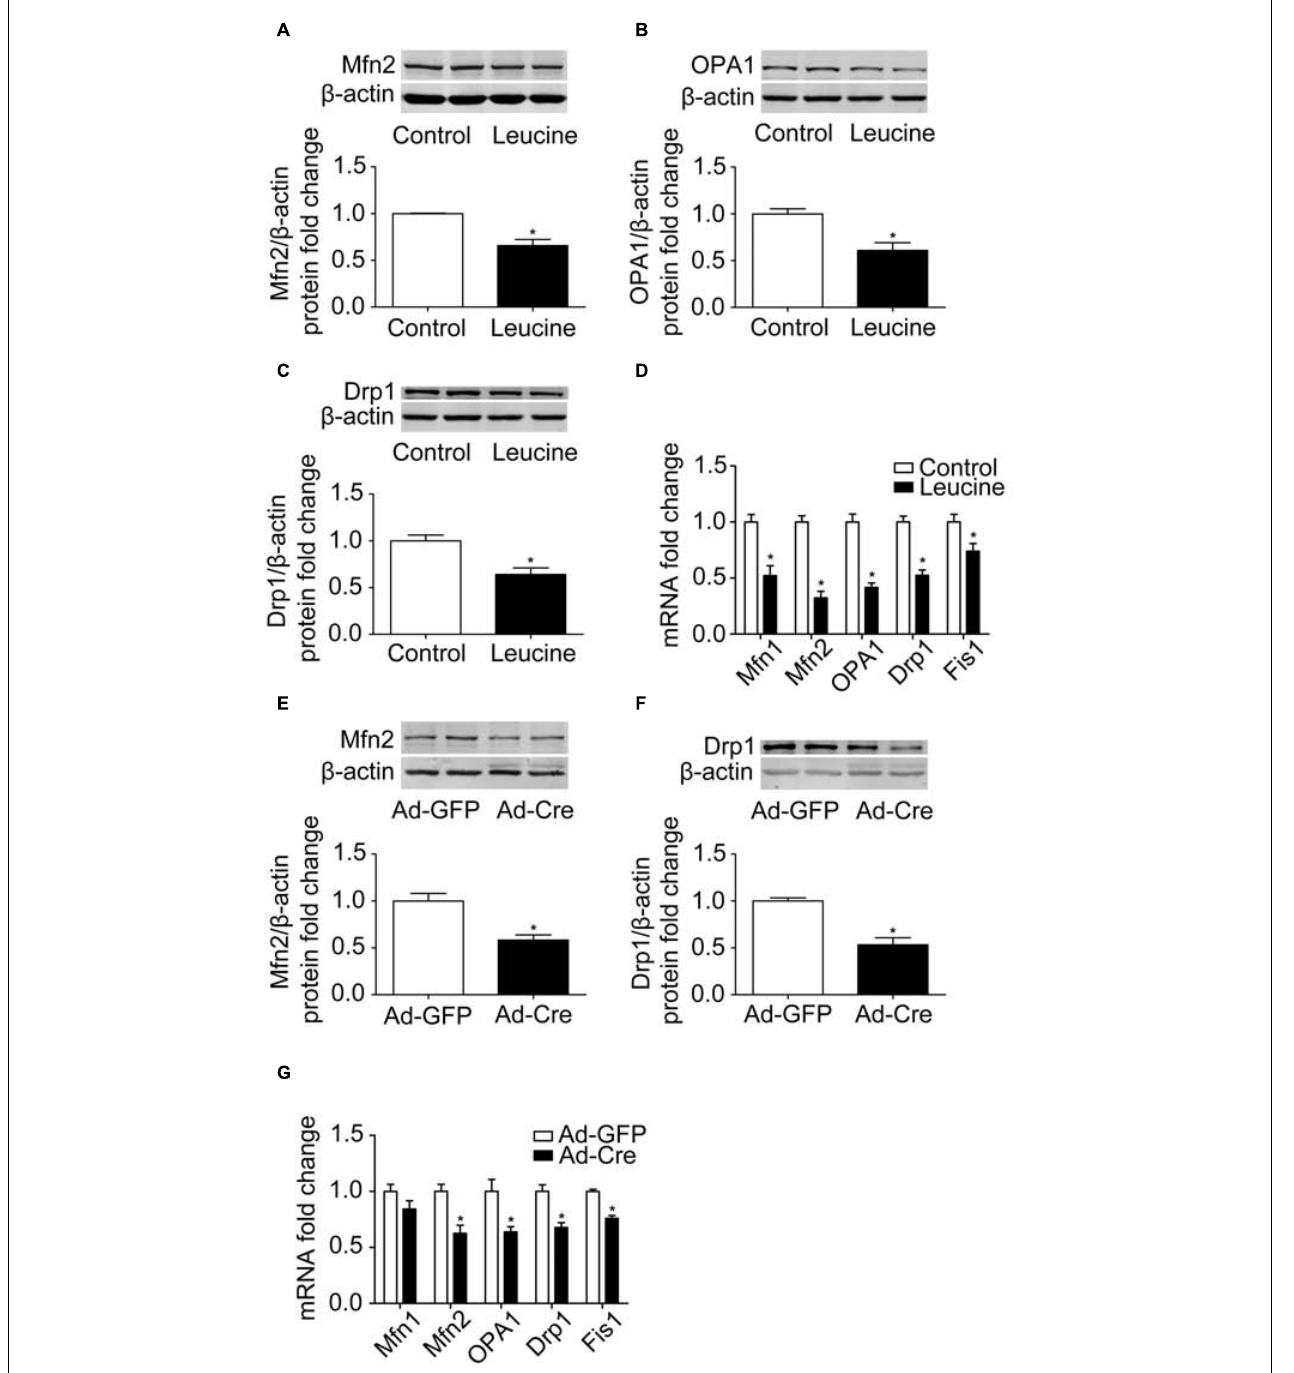
FIGURE 3 | Activation of mTOR inhibits mitochondrial dynamics of brown adipocytes. (A–C) Primary brown adipocytes were isolated from neonatal C57BL/6J mice and cultured for differentiation. Proteins were extracted after 6 days of differentiation. Western blotting of Mfn2, OPA1, and Drp1 was performed with β -actin as a loading control. Relative protein signal intensity was quantified and expressed as means ± SD. (D) Total RNAs were extracted after 6 days of differentiation. Real-time PCR was performed to evaluate the expression of mitochondrial dynamics marker genes with β -actin as a loading control and results expressed as means ± SD. *Denotes P < 0.05 relative to control. (E,F) Tsc1 loxp / loxp brown adipocytes were treated with Cre adenoviruses for 48 h and controls with GFP adenoviruses. RNAs and protein were extracted as described in the methods section. Representative results of western blot for p-S6, S6, Mfn2, and Drp1 are shown. β -Actin was used as the loading control. Relative protein signal intensity was quantified and expressed as means ± SD. (G) Real-time PCR was performed to evaluate the expression of genes related to mitochondrial dynamics. Levels of mRNA expression were normalized to β -actin and expressed as means ± SD. * P < 0.05 vs. Ad-GFP.